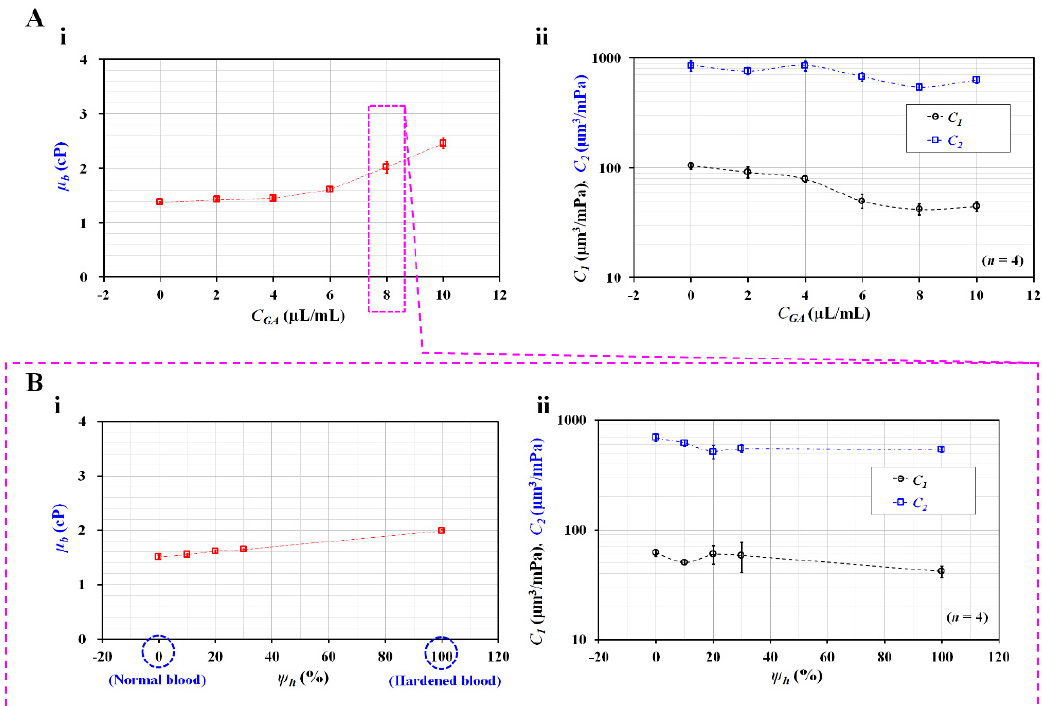
Figure 6. Detection of homogeneous hardened RBCs and heterogeneous hardened RBCs with blood viscosity and two compliances. ( A ) Detection of homogeneous hardened blood composed of RBCs hardened with the same concentrations of GA solution. Normal RBCs were hardened using the specific concentrations of GA solution. After that, hematocrit of blood was adjusted to 50% by adding hardened RBCs into 1× PBS. ( i ) Variations of µ b with respect to concentrations of GA solution ( C GA ) ( C GA = 0, 2, 4, 6, 8, and 10 µL/mL). ( ii ) Variations of two compliances ( C 1 and C 2 ) with respect to C GA . ( B ) Detection of heterogeneous blood composed of normal blood and hardened blood. Hardened blood was prepared by adding hardened RBCs ( C GA = 8 µL/mL) into PBS solution. Speci fi cally, the volume fraction of hardened blood ( ψ h ) was de fi ned as the ratio of hardened blood volume to total blood volume (i.e., ψ h = V h /[ V h + V n ], where V h is the hardened blood volume, and V n is the normal blood volume). ( i ) Variations of µ b with respect to ψ h = 0%, 10%, 20%, 30%, and 100%. ( ii ) Variations